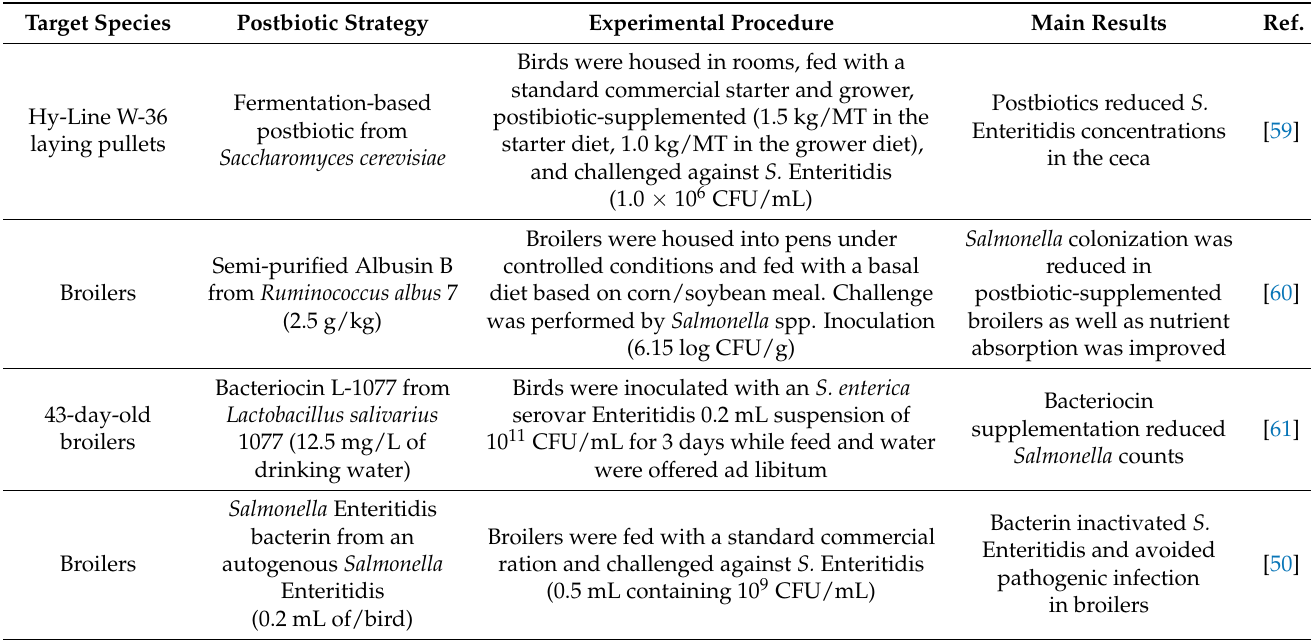
Table 4. Effects of dietary supplementation of postbiotics as a strategy to control Salmonella in